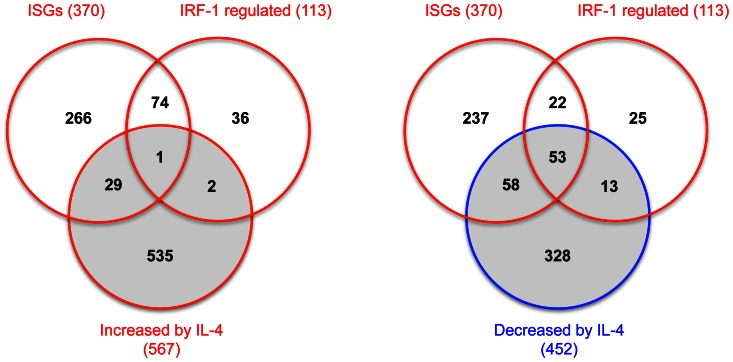
Relationships between genes regulated by Interferon, IRF-1, and IL-4.Venn diagrams showing the overlaps of 370 ISGs and 113 IRF-1 up-regulated genes defined by Schoggins et al. [31] with IL-4-regulated genes (567 up-regulated and 452 down-regulated) identified by Elo et al
[35]. Only genes that were annotated and common to both U133 plus 2 and Human Exon 1.0 ST Affymetrix array platforms (i.e. 16420 genes) were analysed here. Complete gene-lists are available in Data-File S2.